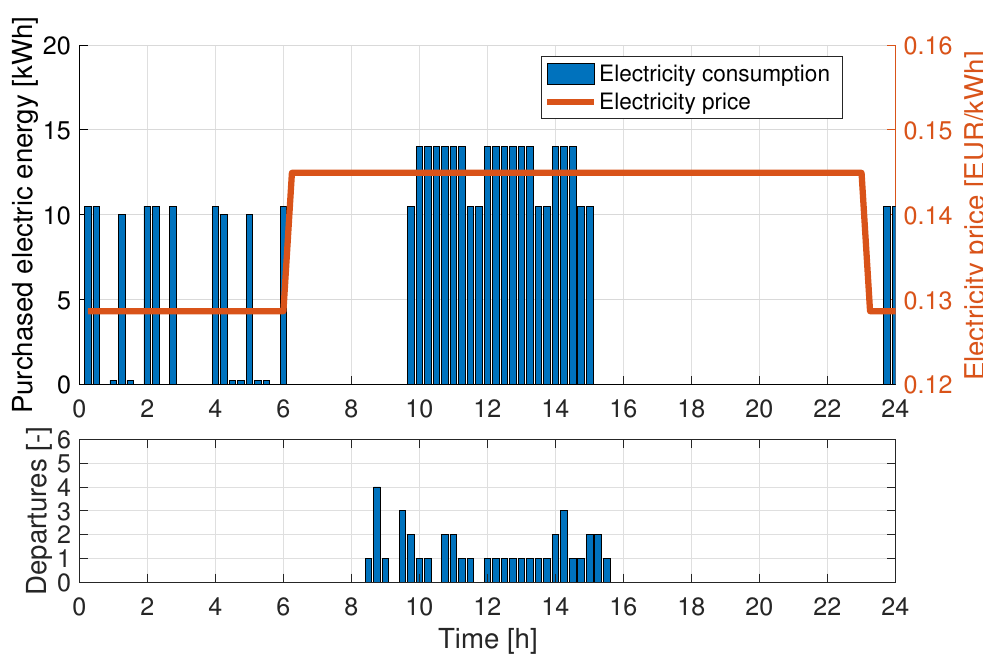
Figure 5. Energy expenditure (top) and departure schedule (bottom) at LIMB for the Most Demanding Day case.